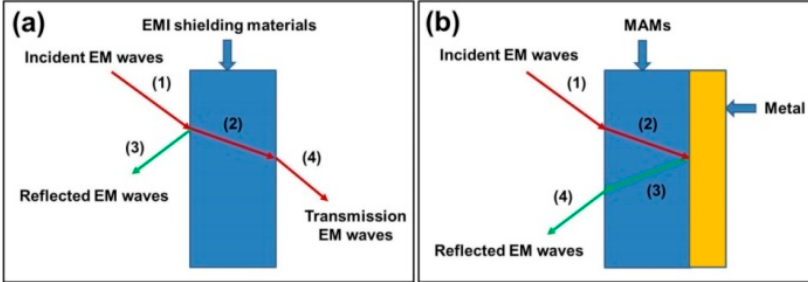
Figure 1. The evaluation models of ( a ) conventional electromagnetic interference (EMI) shielding and ( b ) microwave absorption. MAM: microwave-absorbing material. Polymers 2017 , 9 , 29 4 of 27